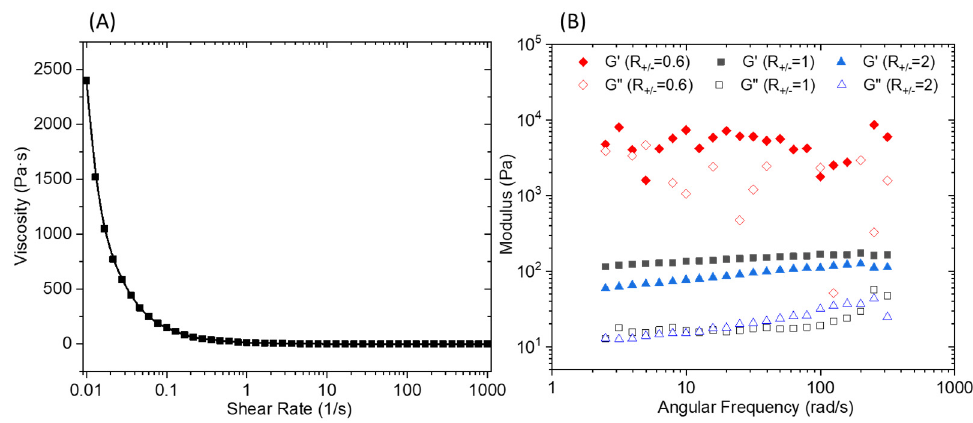
Figure 6. ( A ) Viscosity versus shear rate of the PA/PSSNa physical gel. ( B ) Storage (G’) and loss (G’’) modulus for 10 wt.% solutions of C 16 V 3 A 3 K 3 G-NH 2 –PSSNa in water as a function of frequency at a constant strain of 0.1% and different R +/ − .